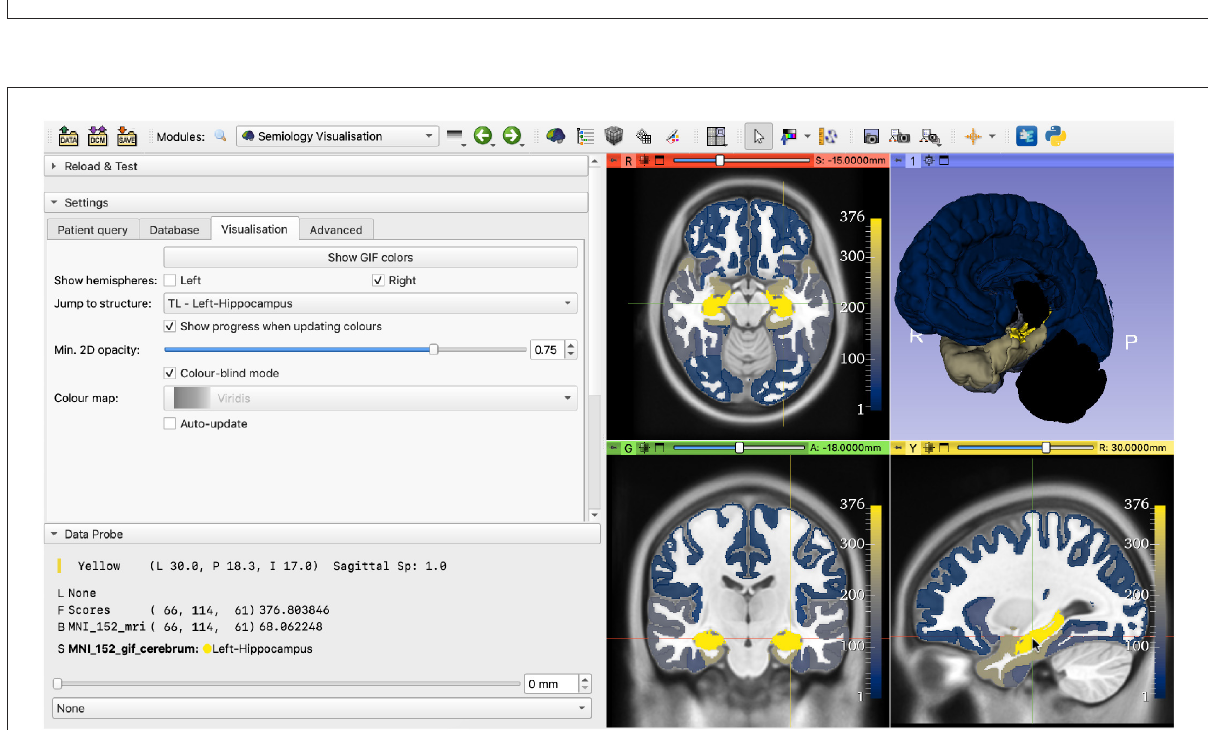
FIGURE5 Results of querying the database with the Epigastric semiology. (Left) Table showing the number of datapoints associated with each brain structure; (Right) EZ probability map, where brightness (and opacity, on the 2D views) is linearly proportional to the number of datapoints.